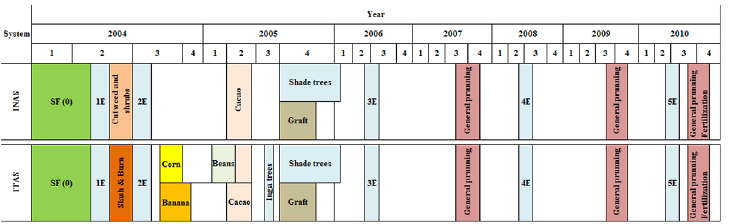
Fig 2. Management practices adapted and sequence of crops adapted in cacao agroforestry systems. SF (0) land under secondary forest before the implementation of cacao, 2004. E = soil sampling, spaces in blank indicates maintenance of cacao.